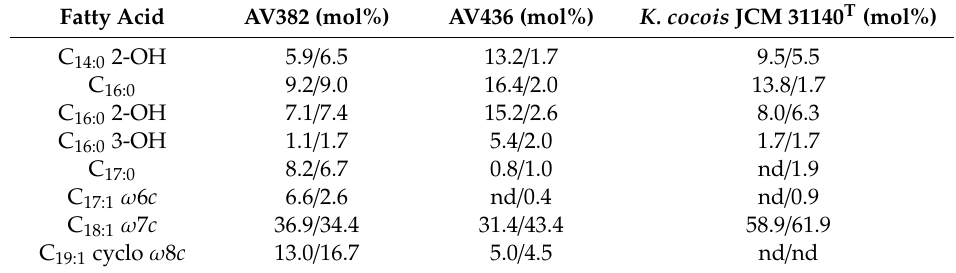
Table 1. Cellular fatty acid profiles of strains AV382, AV436 and Komagataeibacter cocois JCM 31140 T